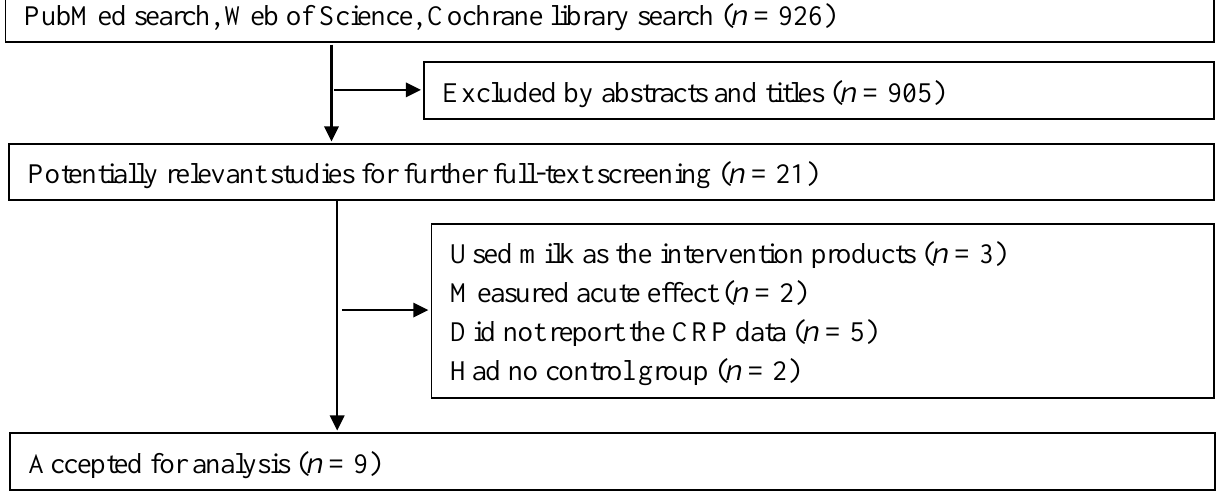
Figure 1. Flow chart of study